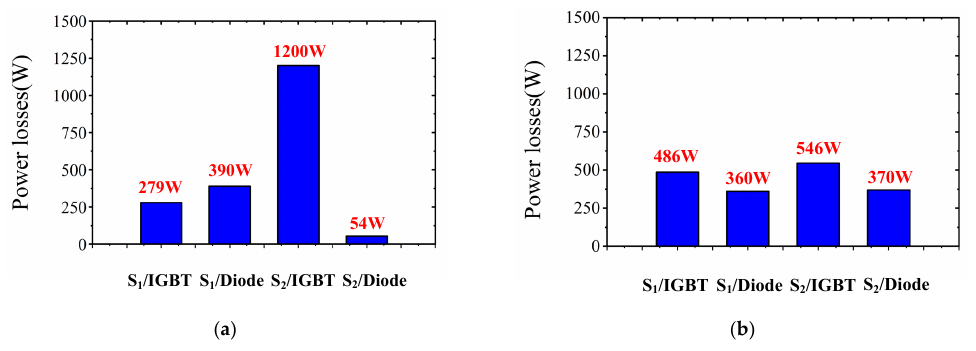
Figure 19. Power loss distributions of the SMs in the proposed hybrid MMC. ( a ) Loss distribution of HBSMs. ( b ) Loss distribution of SCSMs.